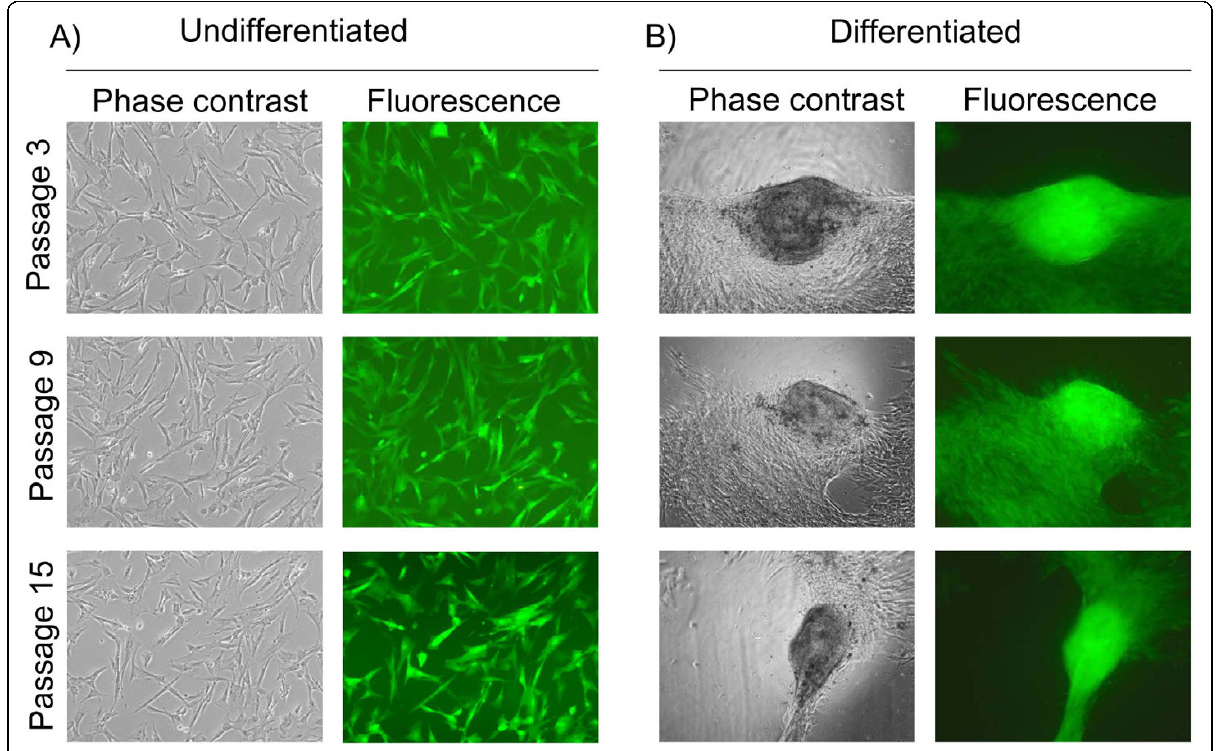
Figure 3 Viral transduction of EADSCs maintains transgene expression . Representative phase contrast and fluorescence images (20×) of undifferentiated (A) and differentiated (B) EADSCs at 3, 9 and 15 passages post lentiviral vector